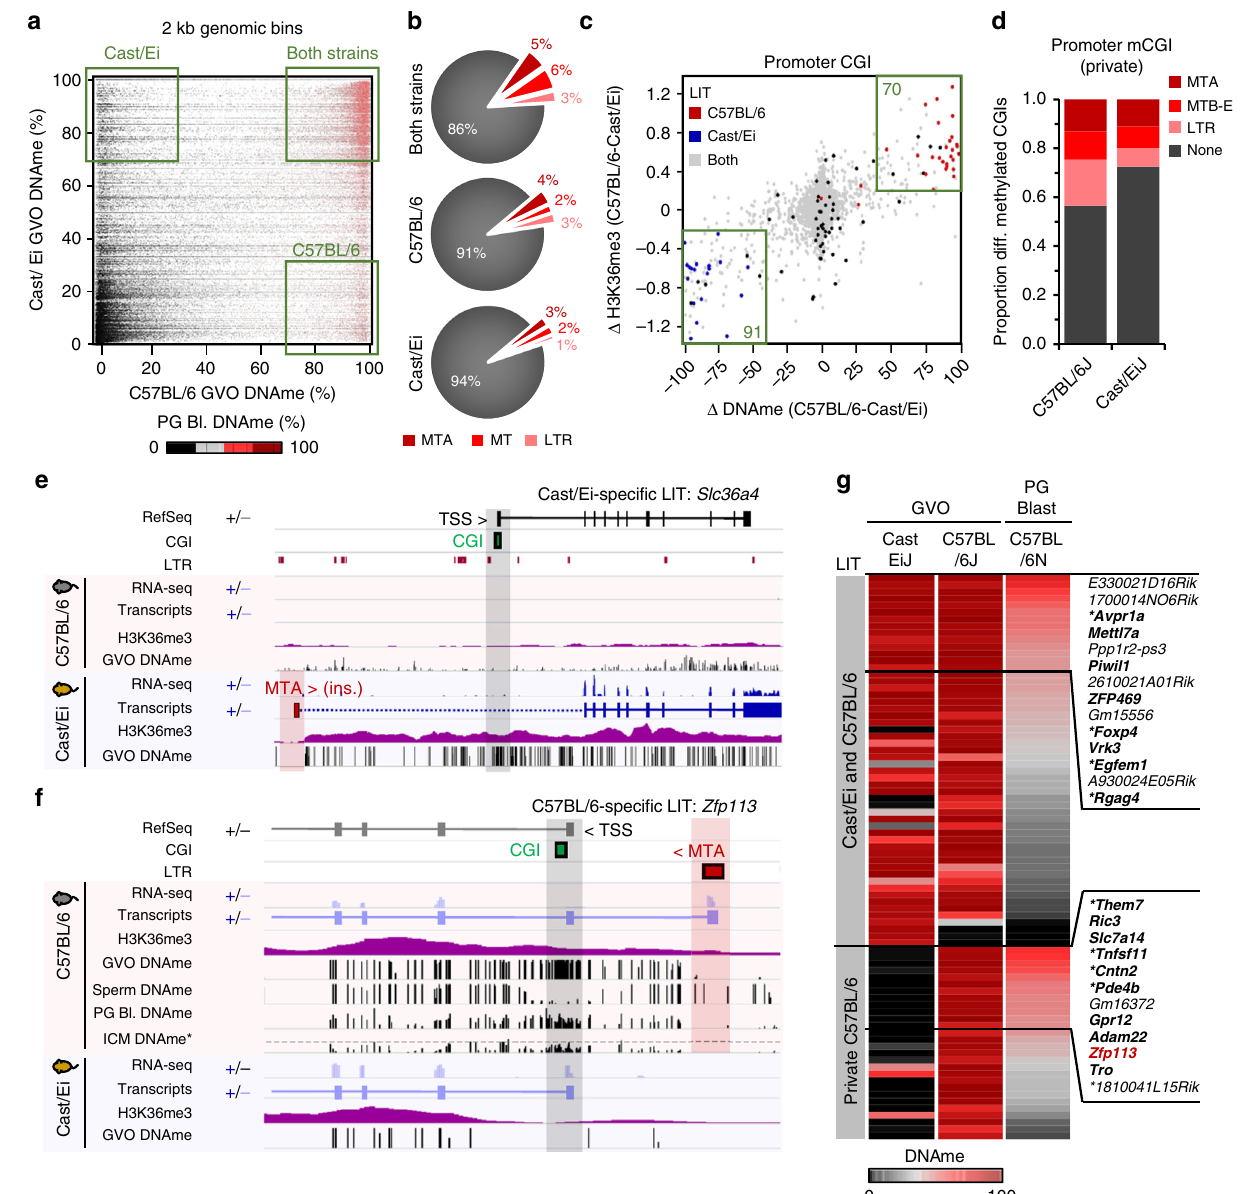
Fig. 6 LTR polymorphisms lead to strain-speci fi c transcripts and CGI DNAme in mouse oocytes. a Density plot of DNAme over 1,101,575 genome-wide 2 kb bins (>3 CpGs >1× coverage in Cast/Ei GVOs) in C57BL/6 or Cast/Ei GVOs. Regions hypermethylated (>70%) in C57BL/6 and/or Cast/Ei GVOs are highlighted. The mean percentage of DNAme in C57BL/6 parthenogenetic blastocysts (PG Bl.) is indicated as a color gradient. b Proportion of 2 kb bins hypermethylated in C57BL/6 and/or Cast/Ei GVOs overlapping with an LIT driven by an MTA element, another subfamily of MT element (MTB, C, D, or E) or another type of LTR. c Scatter plot of differential DNAme ( Δ DNAme) and H3K36me3 enrichment ( Δ H3K36me3) over 11,030 promoter CGIs in C57BL/6 and Cast/Ei GVOs. Differentially methylated CGIs are highlighted in green boxes. d Bar chart depicting each type of transcript overlapping differentially methylated promoter CGIs identi fi ed in c . MTA, MT, or LTR-initiated transcripts were identi fi ed by LIONs and/or manual inspection. None: no transcript or non-LTR initiated transcript. e Screenshot of the Slc36a4 CGI promoter. The Slc36a4 transcript initiates in a polymorphic MTA element (insertion in the Cast/Ei genome) in Cast/Ei GVOs. f Screenshot of the Zfp113 CGI promoter. The Zfp113 transcript initiates in an upstream MTA element in C57BL/6 GVOs but from the canonical TSS in Cast/Ei GVOs. g Heat map of all hypermethylated promoter CGIs (69) embedded within an LIT in C57BL/6 GVOs. DNAme levels in Cast/Ei GVOs, C57BL/6 GVOs, and C57BL/6 PG blastocysts is shown (columns), and CGIs embedded within LITs that are present in both strains or private to C57BL/6 oocytes are clustered (rows). Genes with CGI promoters retaining >45% DNAme in PG blastocysts are labeled. Bold: genes previously identi fi ed as TET targets at the implantation stage (see Fig. 5e). C57BL/6 GVO WGBS and ICM datasets from refs.